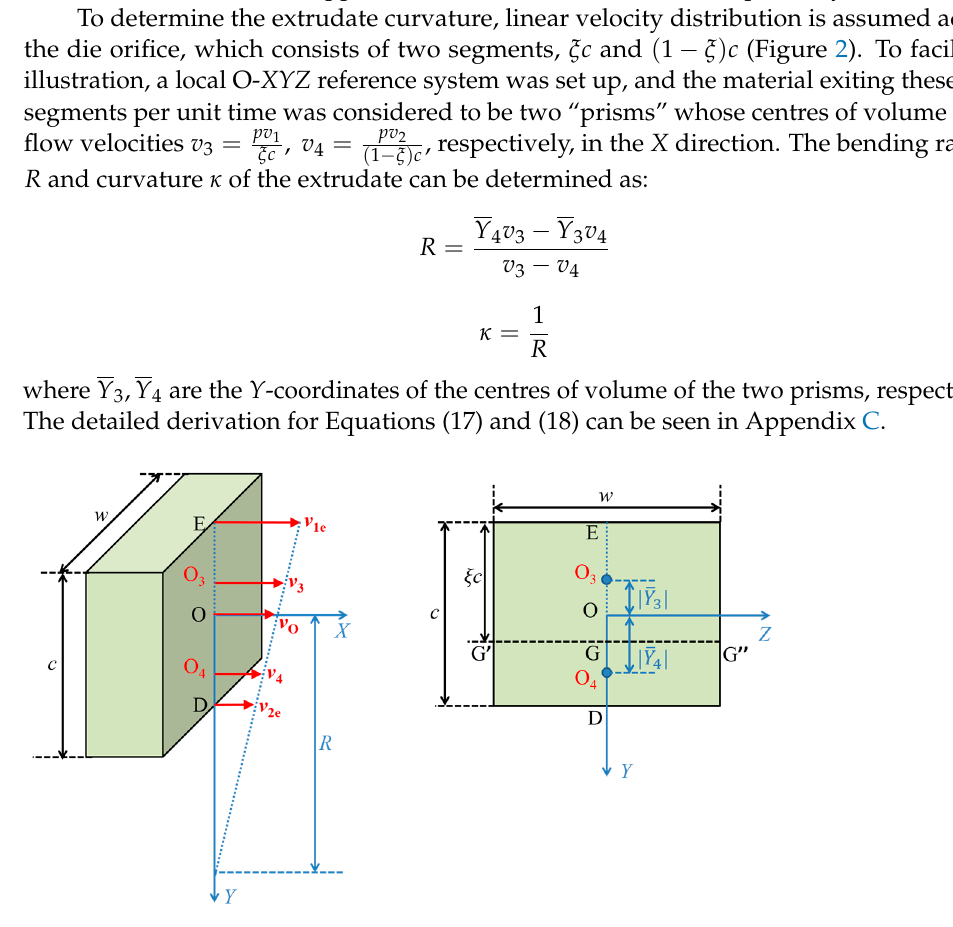
Figure 2. Schematic of the velocity gradient across the die orifice and the bending radius, using the local Cartesian coordinate system O -XYZ . local Cartesian coordinate system O- XYZ